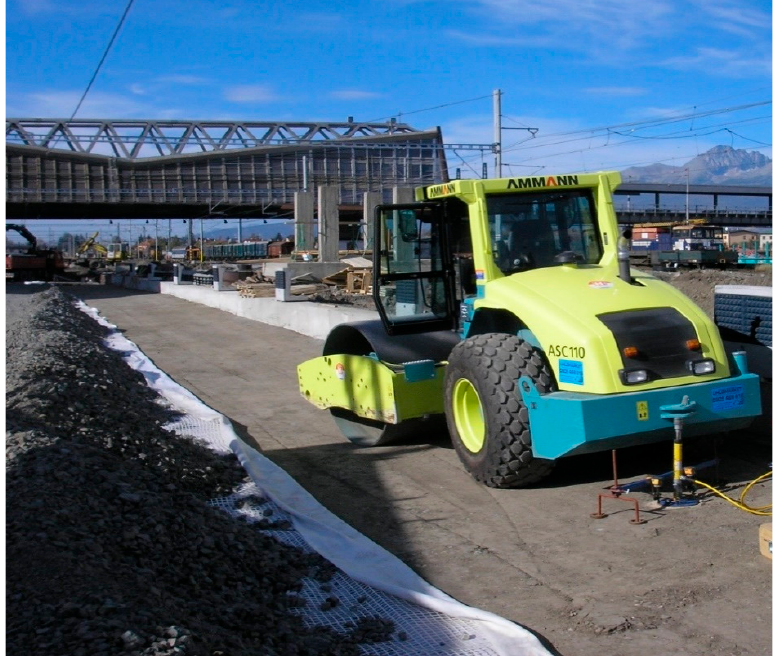
Figure 9. Static load tests on the compacted layer.